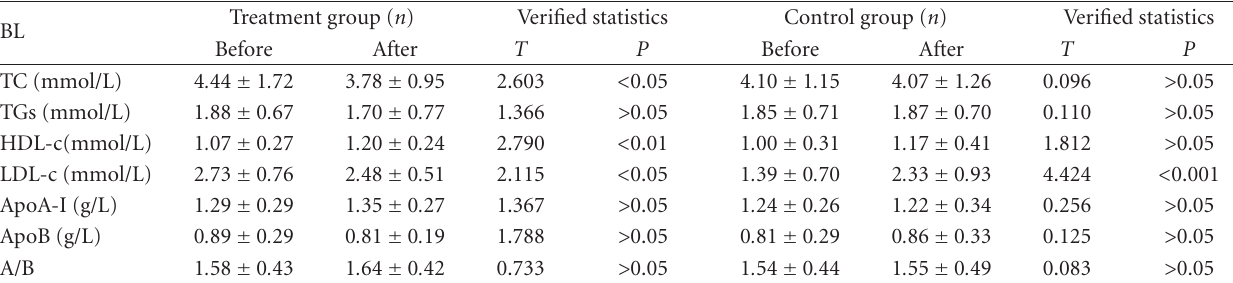
Table 3: Blood lipid index (mean ±